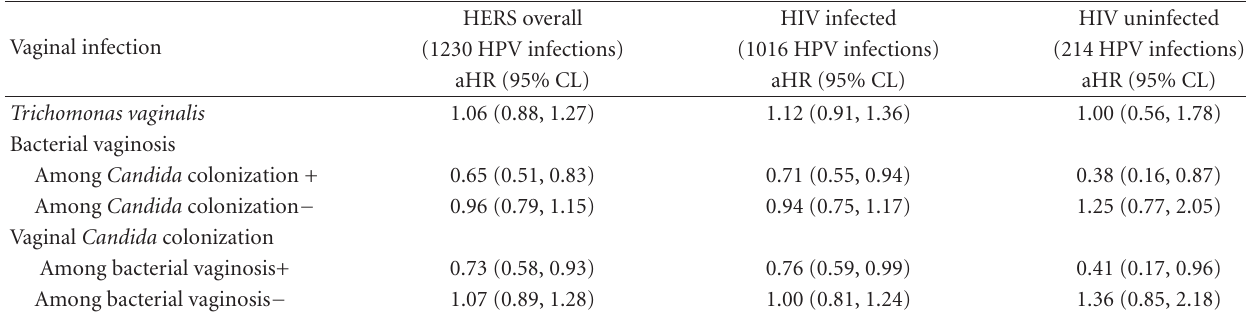
Table 4: Hazard ratios for type-specific clearance of human papillomavirus among all HERS women and by HIV status. HERS overall HIV Vaginal infection